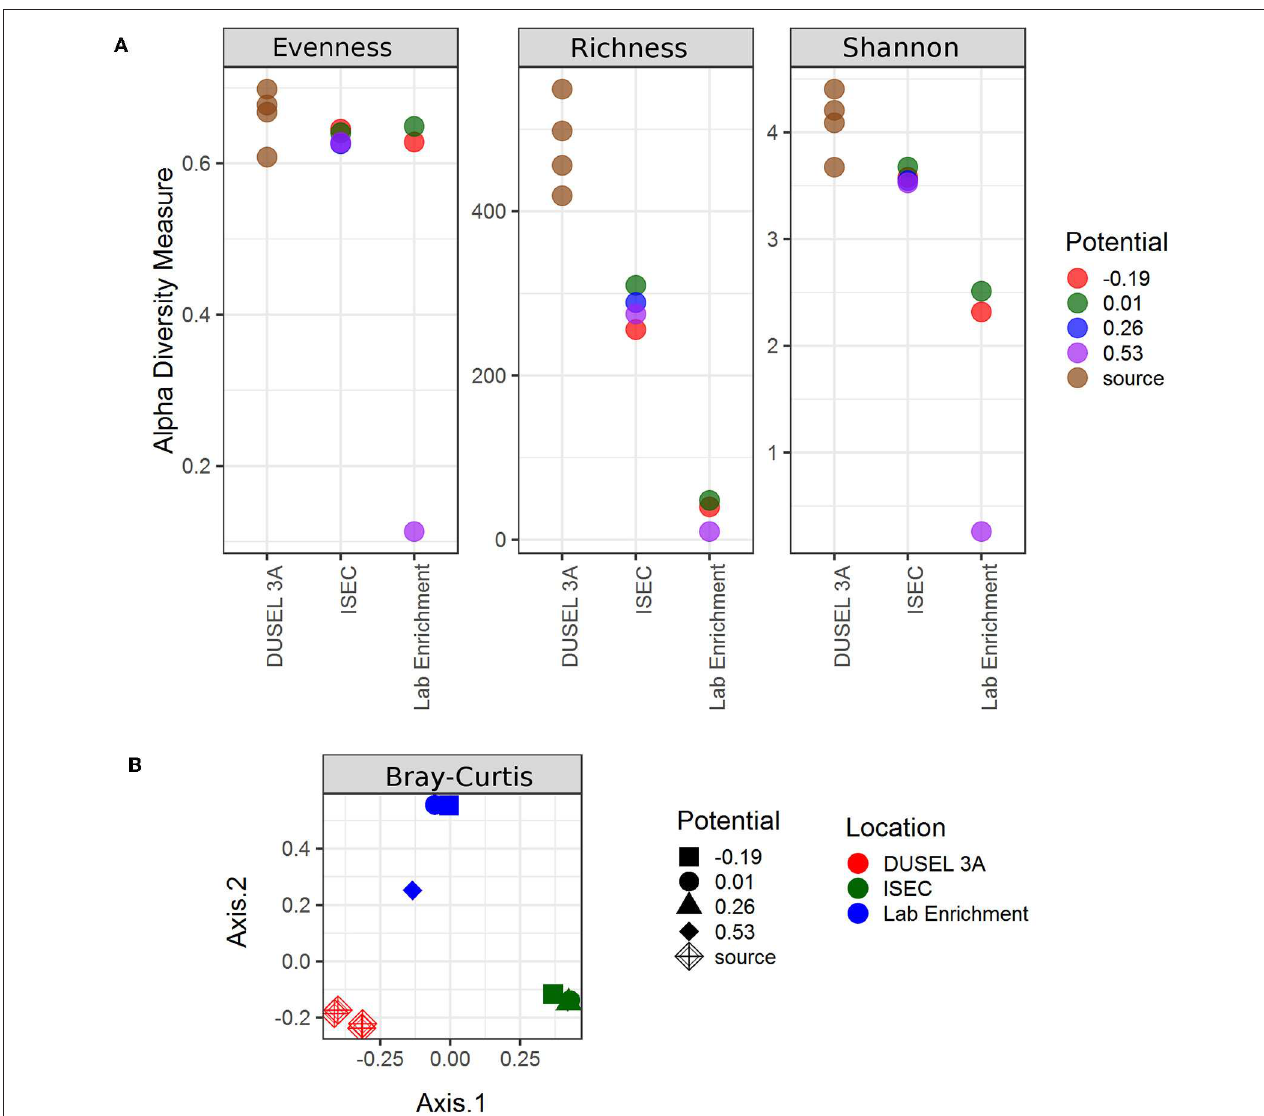
FIGURE 7 | Alpha and beta diversity indices evaluated for the samples. Both the indices point to variation in the microbial community structure from ISEC to lab electrochemical enrichment. (A) Estimates of evenness, richness, and Shannon diversity index of the microbial community as a function of location. (B) Multidimensional scaling plot evaluated using Bray–Curtis method to the clustering of the microbial community based on